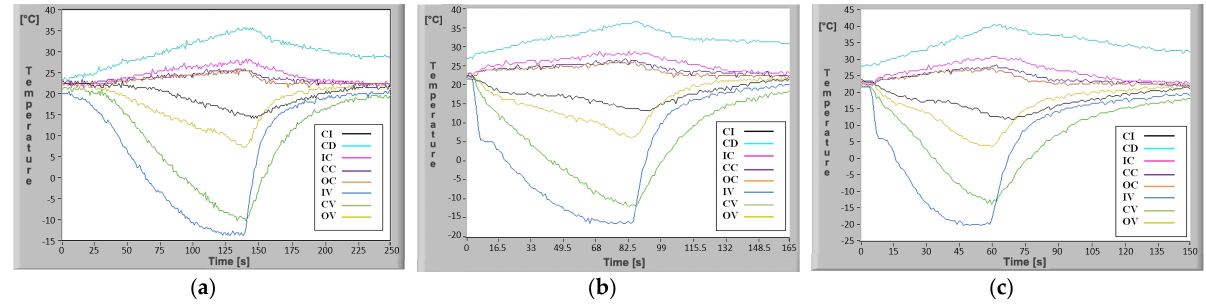
Figure 15. Temperature evolution in rectangular microchannels of the mini refrigeration unit for ASPEN rotary compressor different speeds: ( a ) 1800 rpm, (b ) 4400 rpm, ( c ) 7000 rpm.